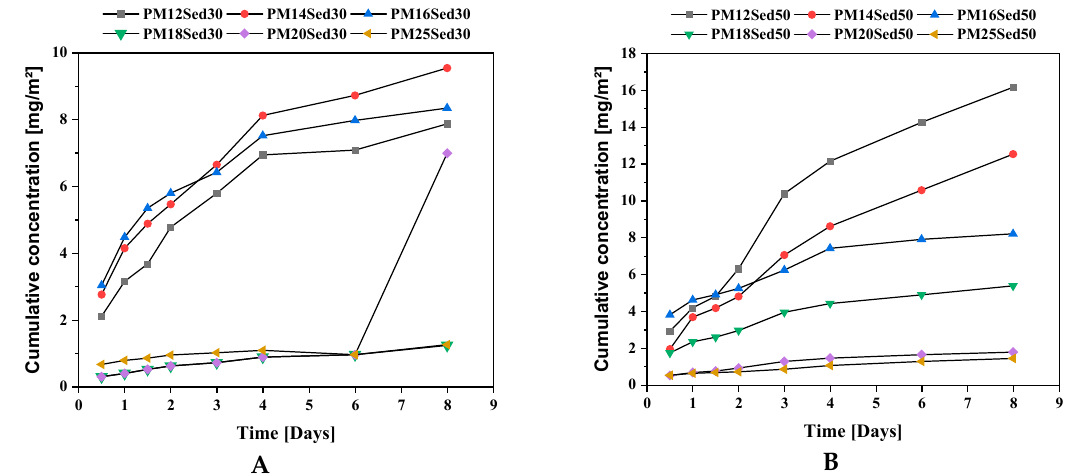
Figure 11. Evolution of cumulative concentration of Cobalt in leachates from monolithic polymer mortars containing 30% ( A ) and 50% ( B ) of sediments in their matrices.